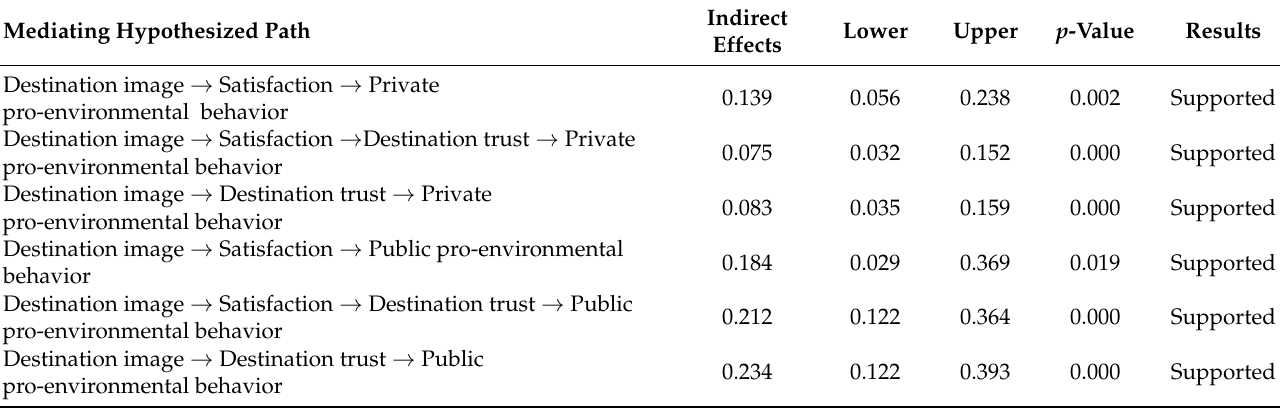
Table 5. Specific mediating